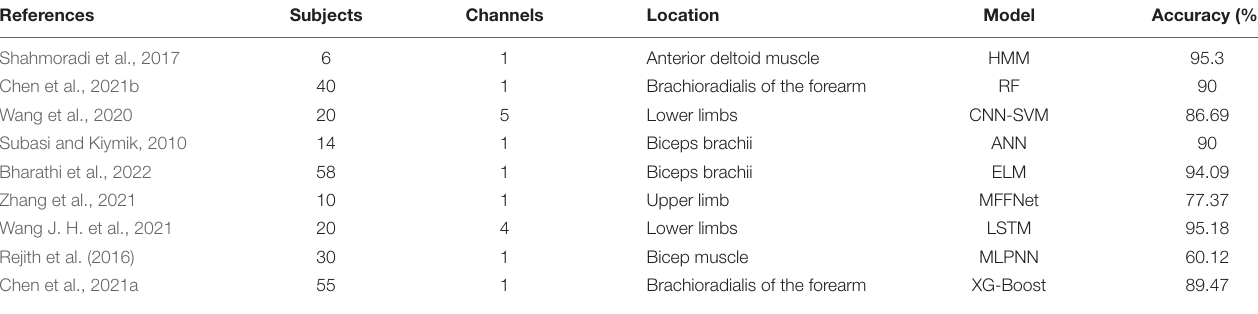
TABLE 1 | Machine learning algorithms for fatigue